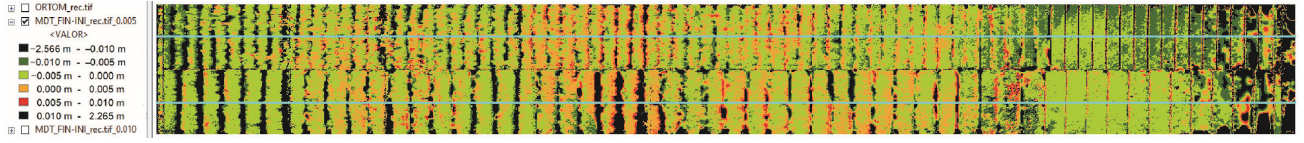
Figure 15. Raster difference between the initial and final DTM. Small blocks in the top half of the coloured area and medium blocks in the lower half. The flow direction is from right to left of the figure.